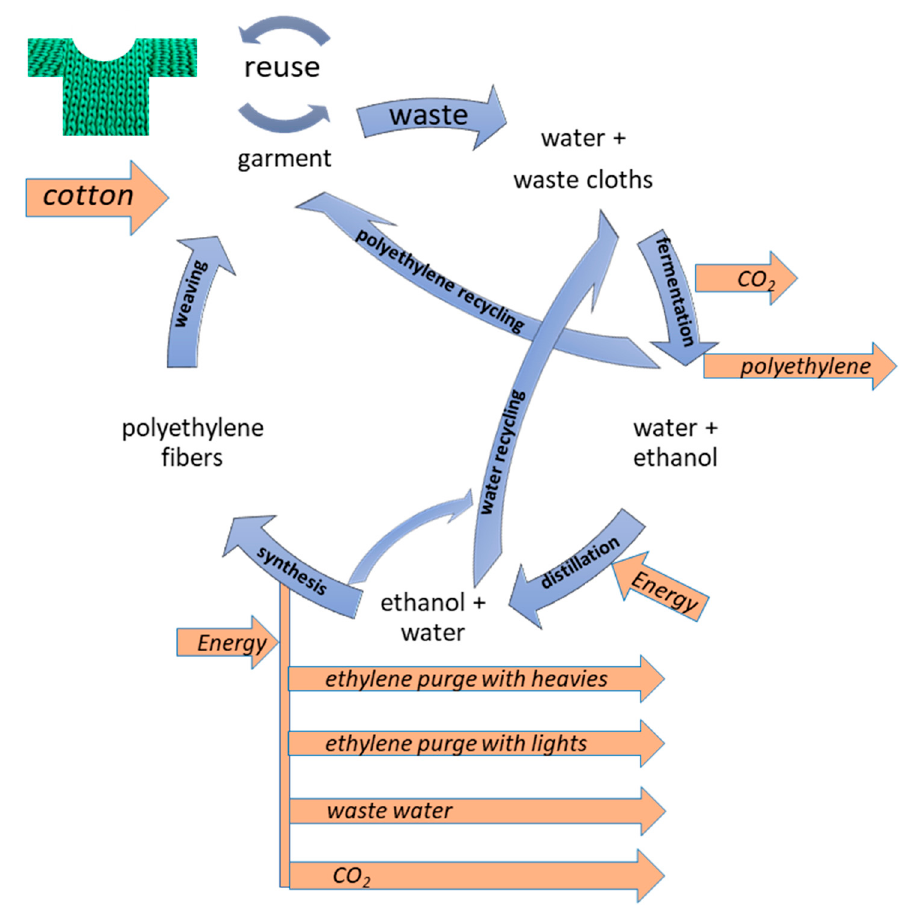
Figure 3. Model formulation.